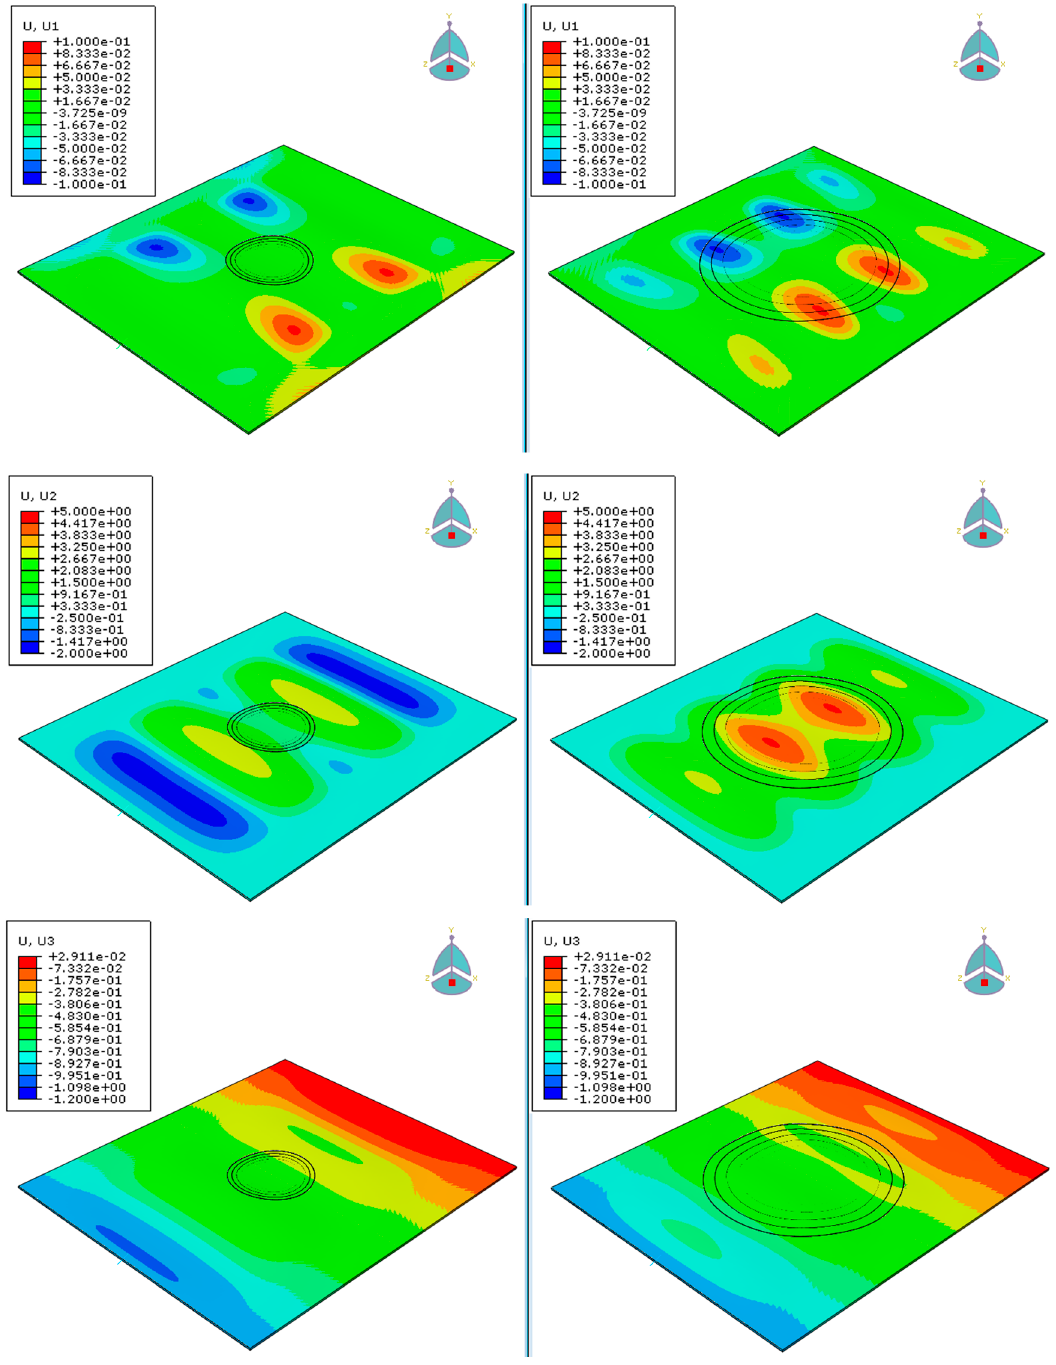
Figure 7. Displacements in X, Y and Z-axis for repair with 20 ( left column ) and 50 scarf ratio ( right column ).